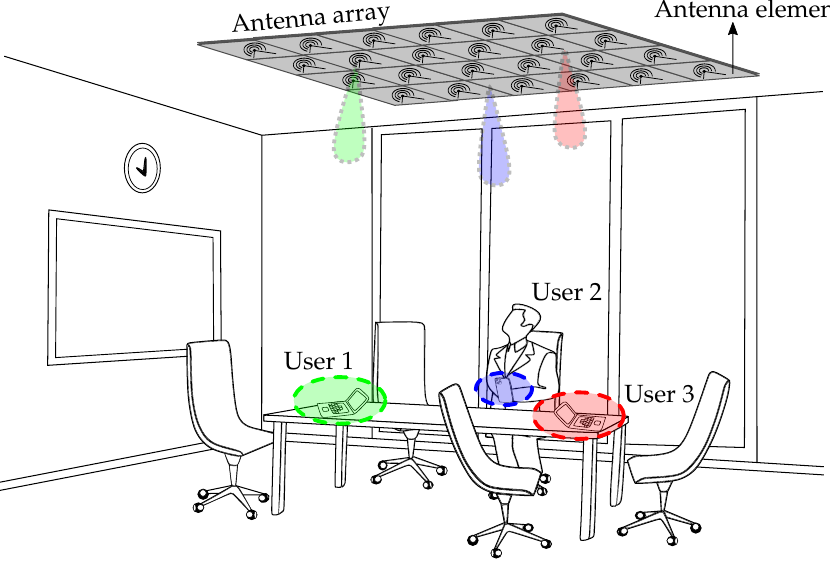
Figure 1. Application scenario. Users are distributed in the radiative near-field of the antenna array. Each user is targeted by an individual focal spot to ensure the best quality of